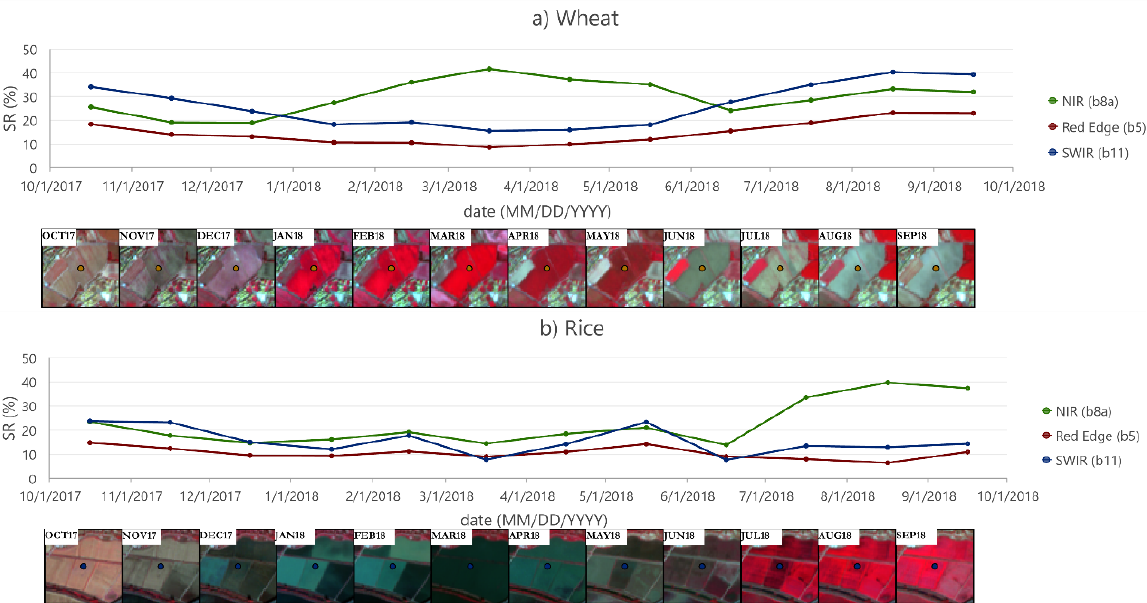
Figure 8. Average surface reflectance in the Red Edge (B5), NIR (B8a), and SWIR (B11) for wheat (a) and rice (b) from October17 to